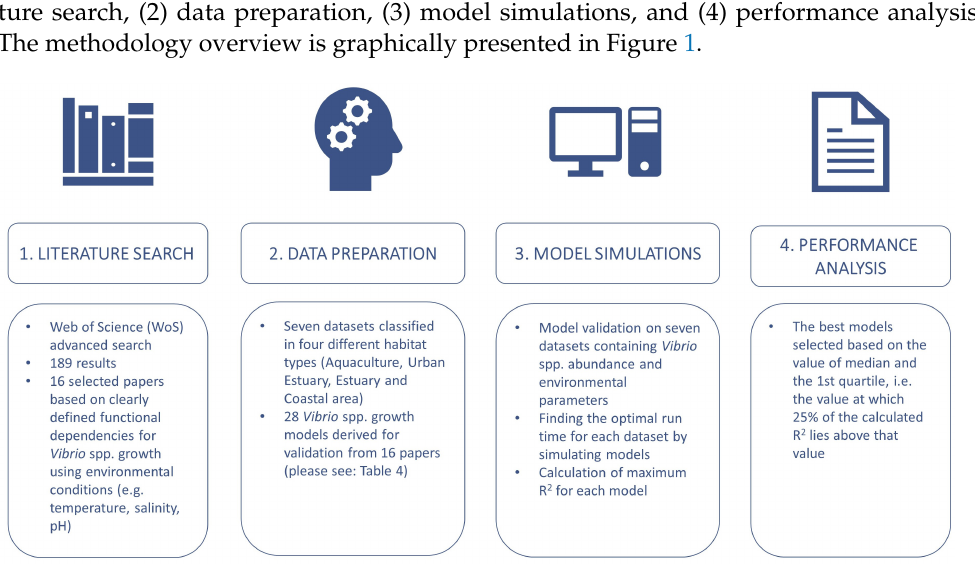
Figure 1. The methodological approach to model analysis. We performed a literature search to find all Vibrio spp. growth models and all available datasets suitable for comparison. We found five published datasets, and included two of our own collected through projects AqADAPT and AQUAHEALTH of the Croatian Science Foundation